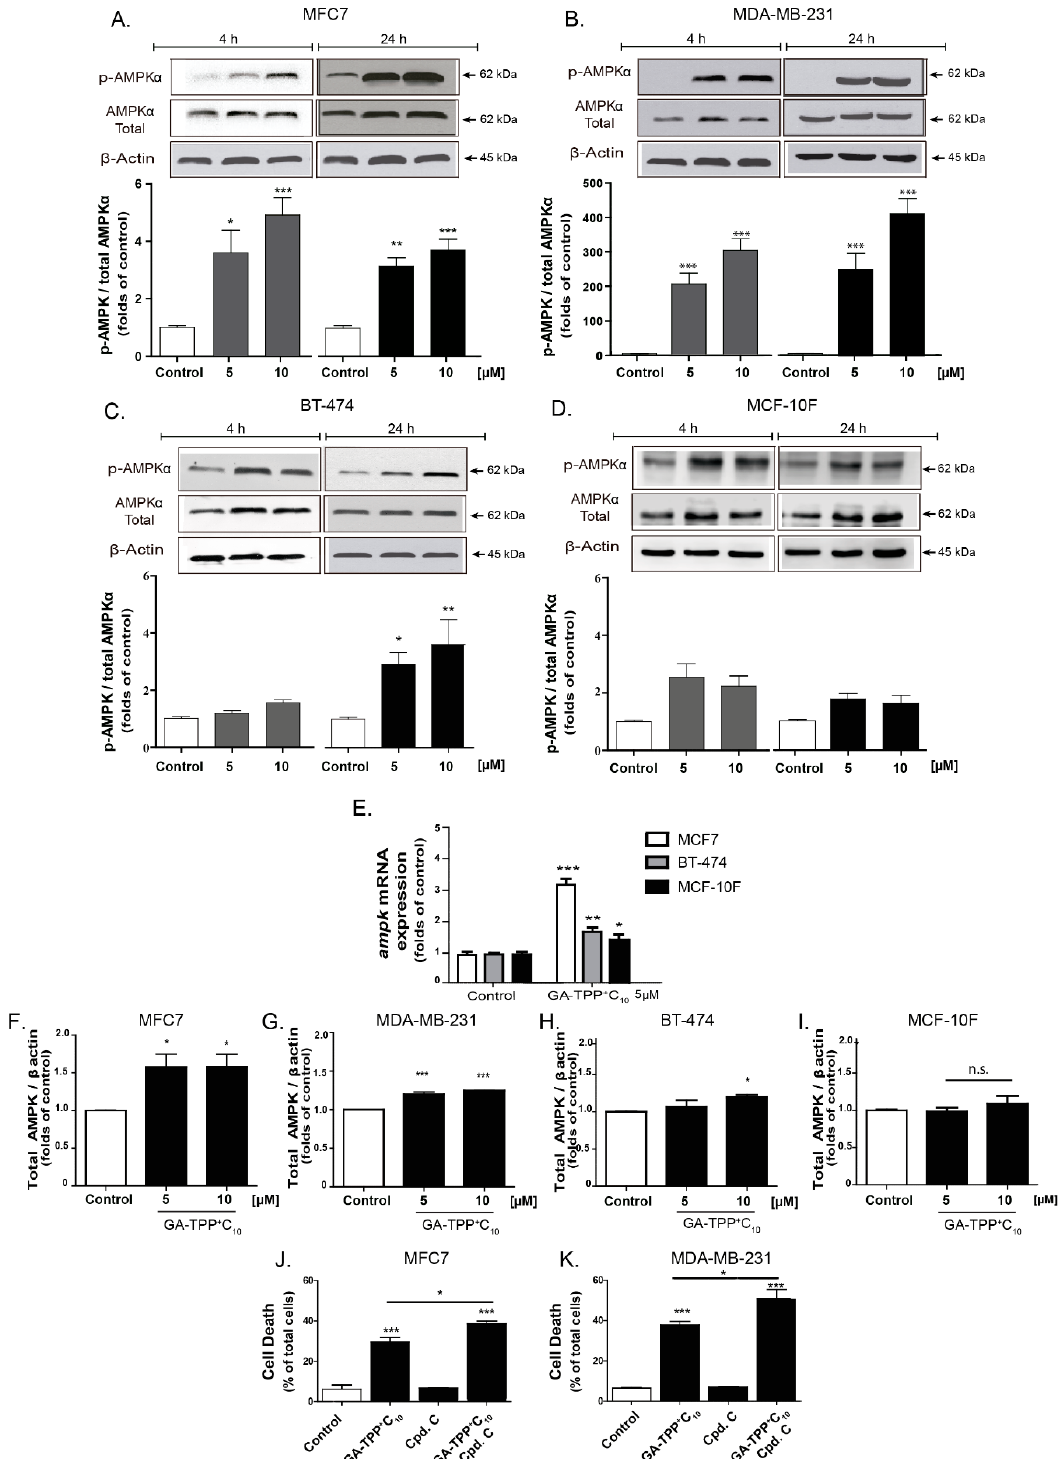
Figure 5. Prosurvival AMPK activation induced by GA-TPP + C 10 . ( A – D ) Phospho-AMPK levels induced by GA-TPP + C 10 at 4 and 24 h of exposure in the BC cells and the epithelial cells. ( E – I ) Increased ampk mRNA and protein expression induced by GA-TPP + C 10 in the BC cells and the breast epithelial cells after 24 h of exposure. ( J , K ) Effect of the decreased prosurvival AMPK on viability in the MCF7 and MDA-MB-231 cells incubated with GA-TPP + C 10 after 24 h. Values are expressed as the mean ± SEM of three independent experiments. * p < 0.05, ** p < 0.01, *** p < 0.001 vs. the control